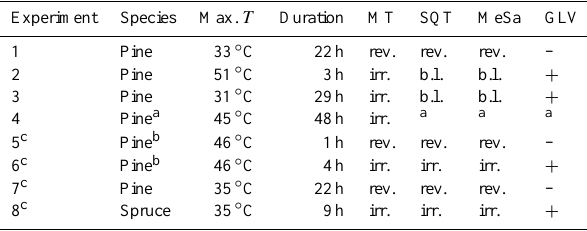
same individual. c Experiment with infested plants.